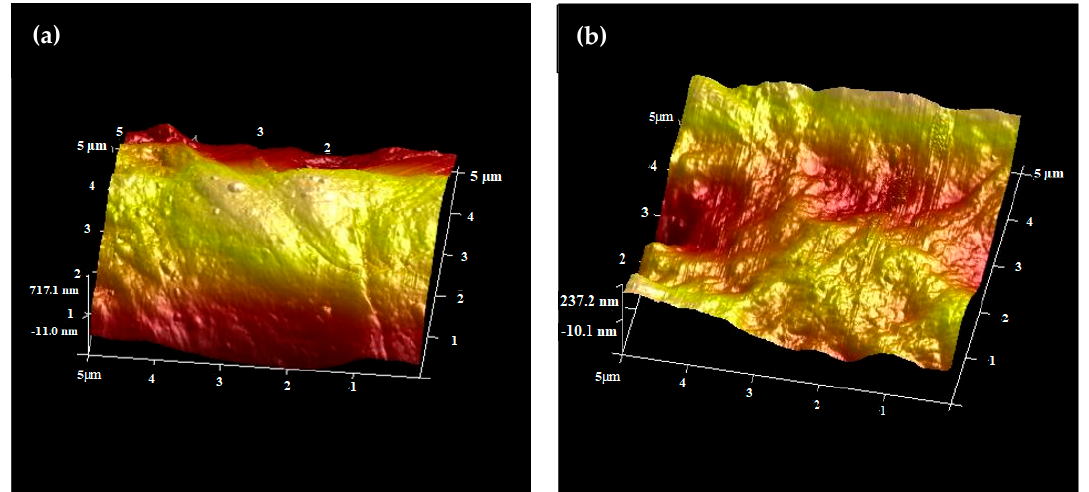
Figure 4. Three-dimensional AFM images of ( a ) bare LLDPE and ( b ) 8%-ZT@LLDPE.